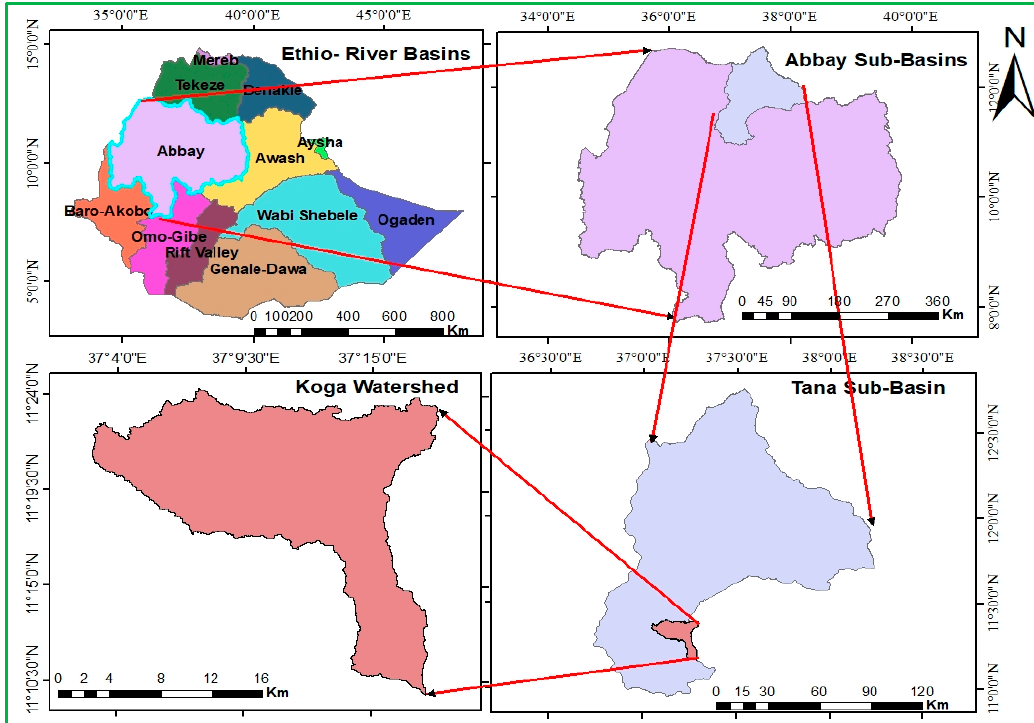
Figure 1. Location of the study area.